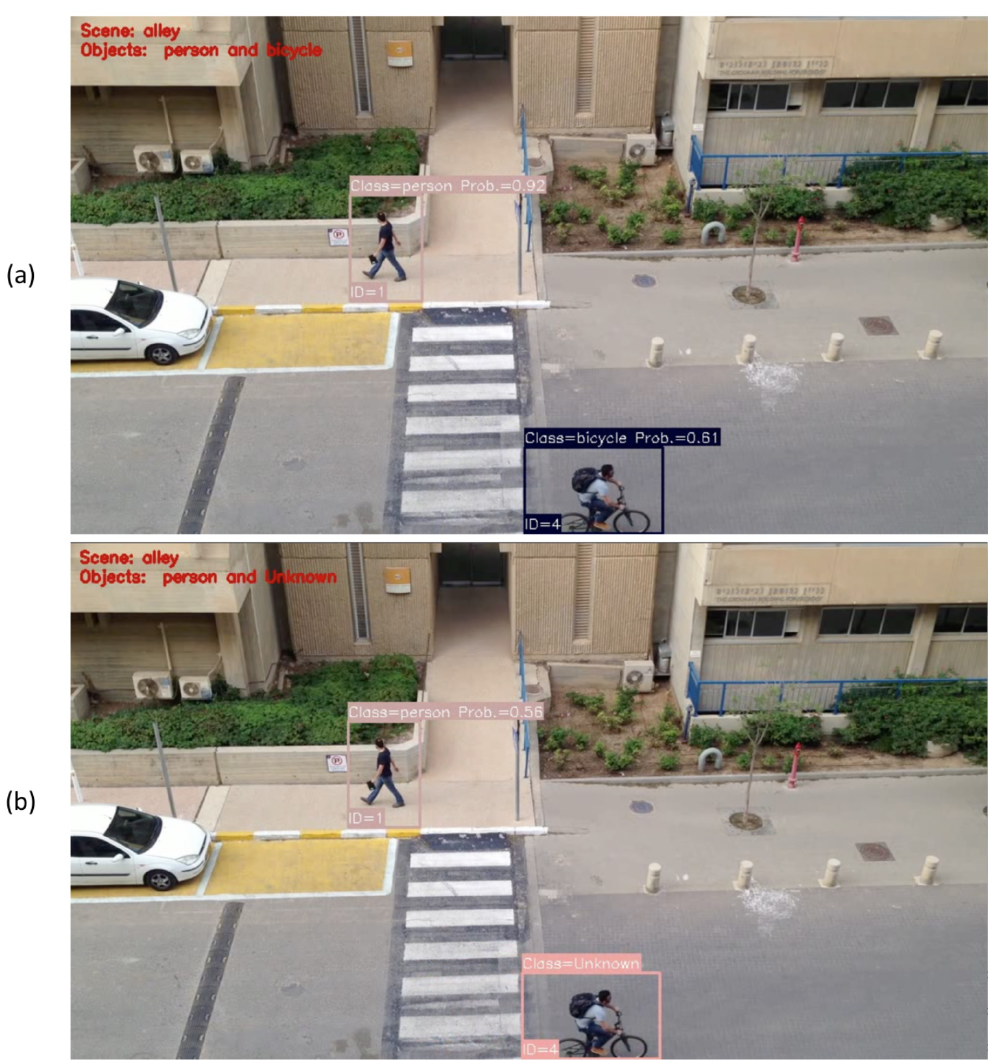
Figure 14. Example of the VAP system operation. While the results of the VAP model, after watching the alley for about 30 min, resulted in high confidence recognition of the objects ( a ), using the same model without reinforcement learning resulted in failure to recognize one object and recognition of the other one with low confidence ( b